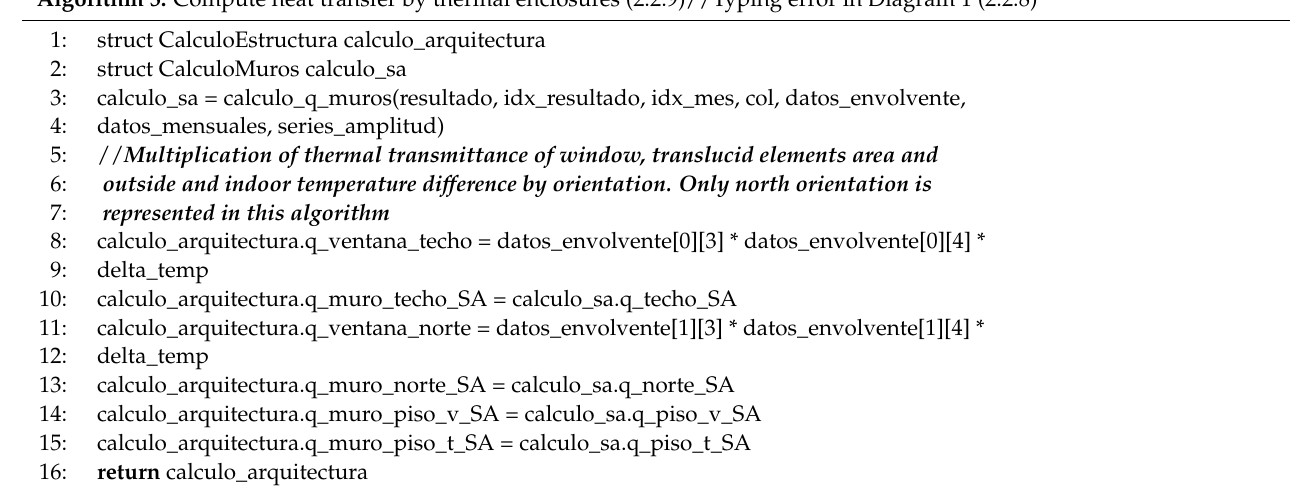
Algorithm 5 calculates the heat transfer between thermal bridges. The calculation ob- tains the area of the total translucent elements of the corresponding orientation, multiplied by the thermal transmittance of the translucent material. Finally, the value of the difference between the external and internal temperatures is multiplied. Algorithm 5. Compute heat transfer by thermal enclosures (2.2.9)//Typing error in Diagram 1 (2.2.8)